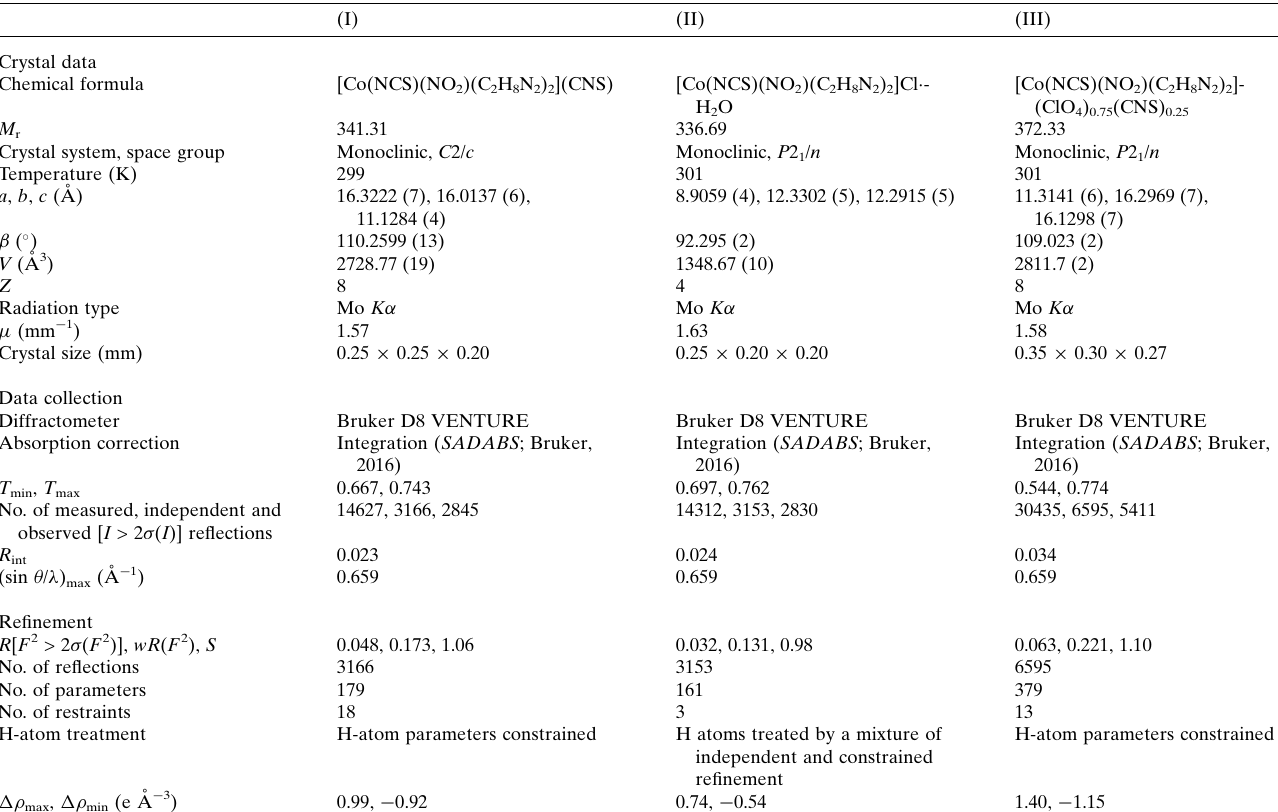
Table 4 Experimental details.